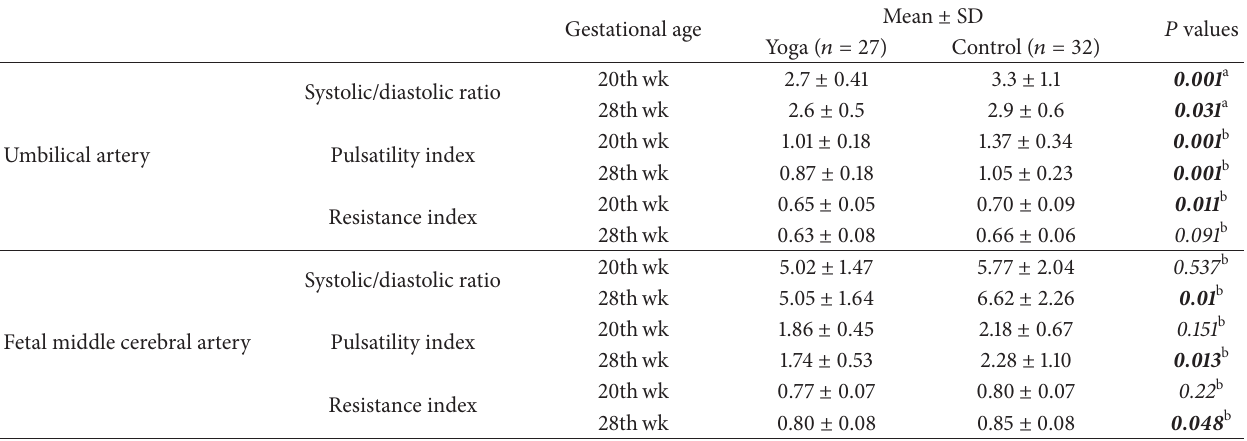
Table 5: Fetoplacental circulation between